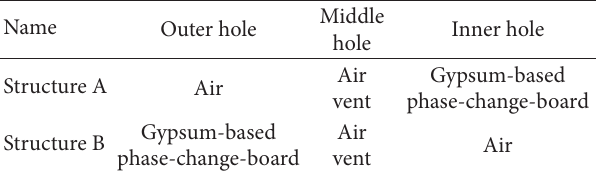
Table 1: The list of construction of external south wall. Name